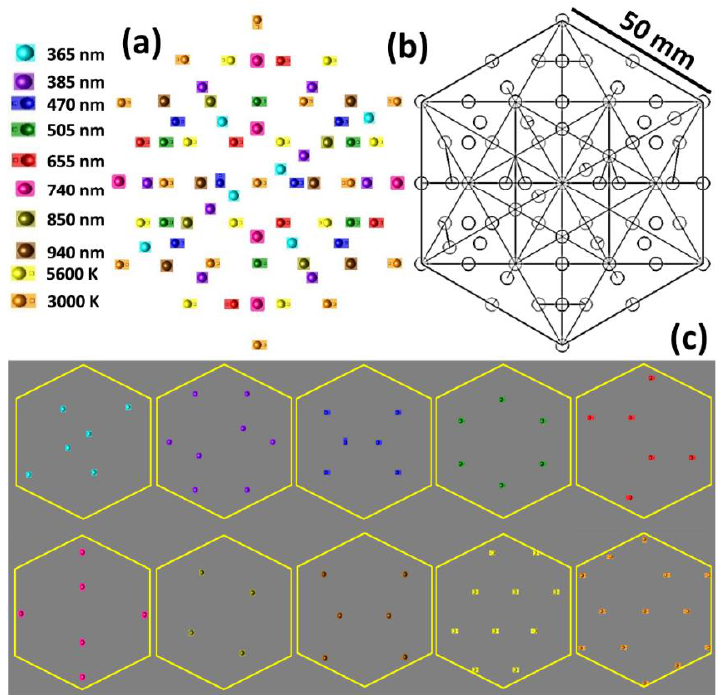
Figure 2. ( a ) One hexagon module loaded with 71 LEDs of ten colors. ( b ) The optimized layout of the 10 distinct color LEDs inside the 50 mm side-length hexagonal unit. ( c ) The number of LEDs and the corresponding arrangement for each individual LED light source inside the hexagonal unit (365 nm: 6 LEDs, 385 nm: 8 LEDs, 470 nm: 6 LEDs, 505 nm: 6 LEDs, 655 nm: 6 LEDs, 740 nm: 6 LEDs, 850 nm: 4 LEDs, 940 nm: 6 LEDs, 5600 K: 10 LEDs, and 3000 K: 13 LEDs).